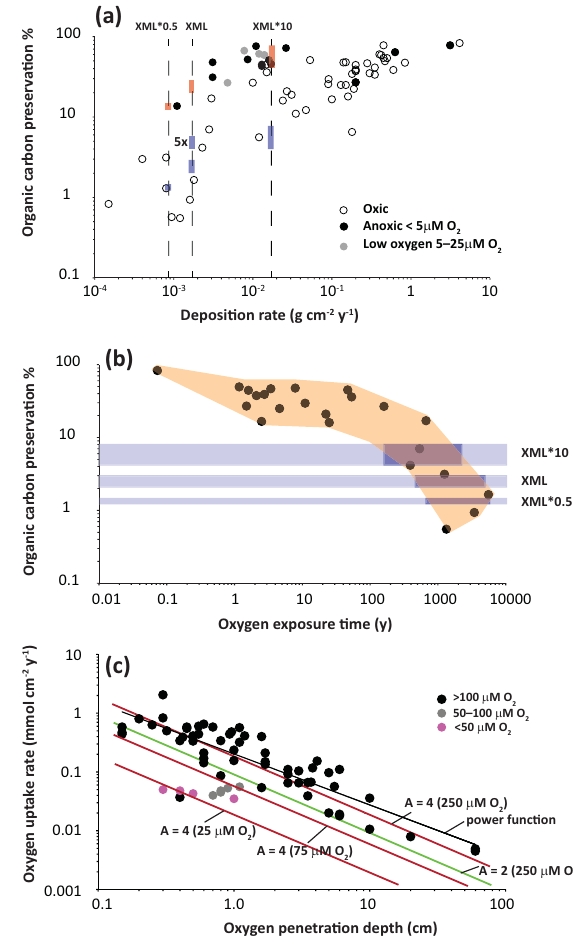
Figure 4. (a) Preservation of organic carbon in modern marine sed- iments calculated as % of carbon buried in a sediment compared to the carbon deposited to the sediment surface. Redrafted from (Can- field, 1994). The vertical lines represent the different sedimenta- tion rates used in the modeling. The upper red rectangles highlight the carbon preservation for the anoxic environments in the compi- lation, while the lower blue rectangles are 10 times less than this, representing the estimated range of carbon preservation in Xiama- ling oxic sediments. For the XML (see text) sedimentation rate, a blue rectangle at 5 times less carbon preservation is also shown, (b) oxygen exposure time vs. organic carbon preservation in marine sediments. The long horizontal lighter blue boxes reflect the range of oxic sediment carbon preservation at the different sedimentation rates used in the modeling (see a ), while the demarcated short dark blue fields show the range of associated oxygen exposure times. Oxygen exposure time data summarized in Table S4. (c) Oxygen- penetration depth vs. oxygen uptake rate from modern marine sed- iments with variable bottom-water oxygen concentrations. Data are from Table S5. Black line indicates the best power-function fit to the data. Red lines indicate fits from Eq. (4) to the data at different bottom-water oxygen concentrations and A = 4. Green line repre- sents model fit from Eq. (4) with A = 2 and 250 µMO 2